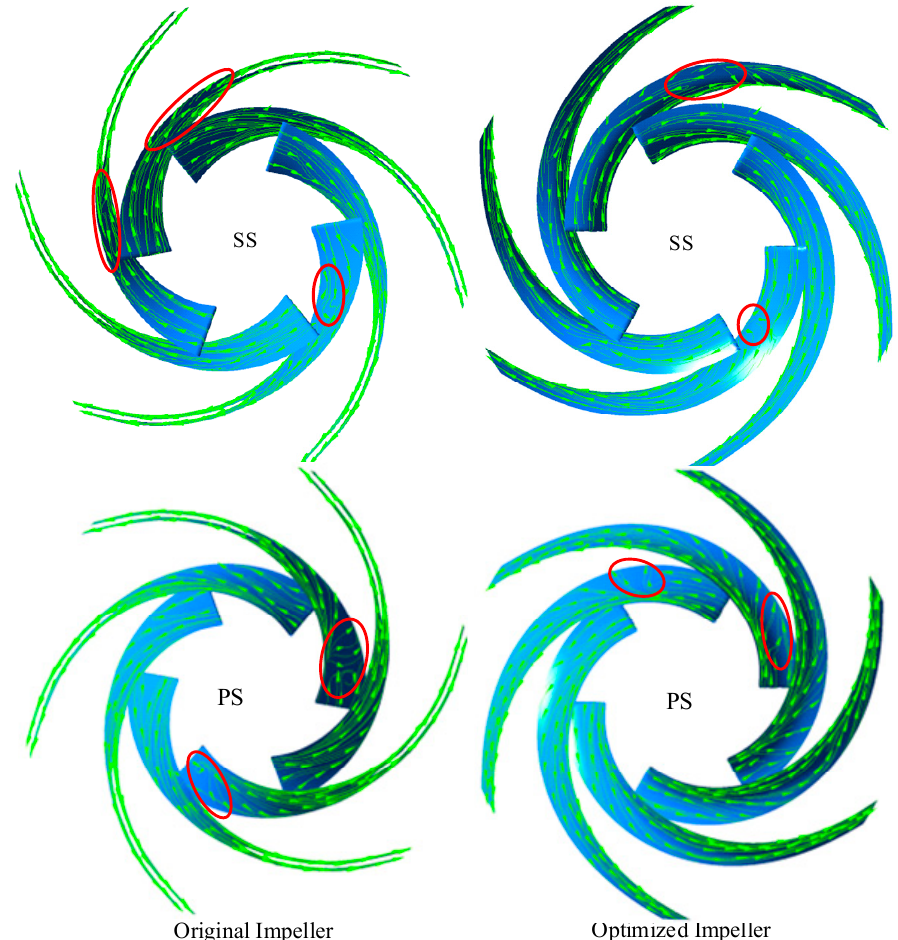
Figure 20. Compare streamline on blade surface at cavitation condition.